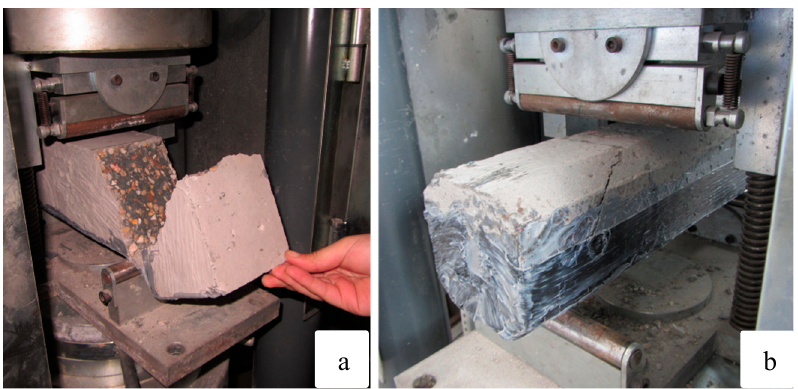
a b Figure 4. ( a ) Standard prismatic test specimens with reinforcement on the lower face. ( b ) Modified prismatic test specimen with reinforced lower face, chamfers, and side walls.